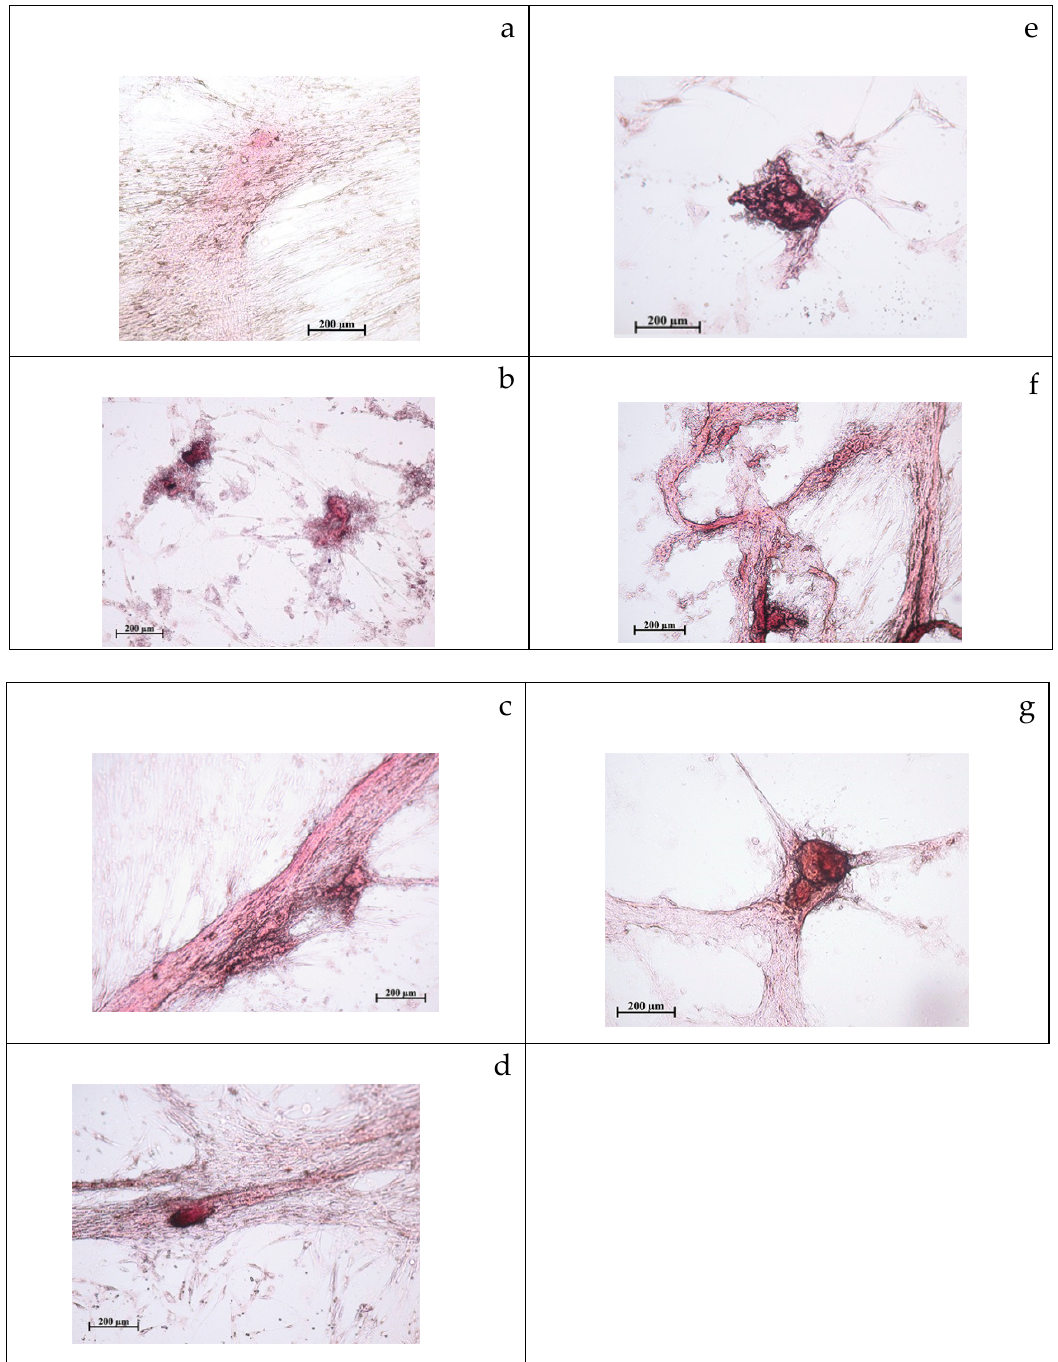
Figure 1. Culture of human adipose-derived multipotent mesenchymal stromal cells after 21 days of cultivation in a standard nutrient medium α -MEM with the addition of the different doses of tested compounds: a—control; b—10 mg/L of F-SC; c— 30 mg/L of F-SC; d—50 mg/L of F-SC; e—10 mg/L of PS-SC; f—30 mg/L of PS-SC; g—50 mg/L of PS-SC. Staining with alizarin red S.